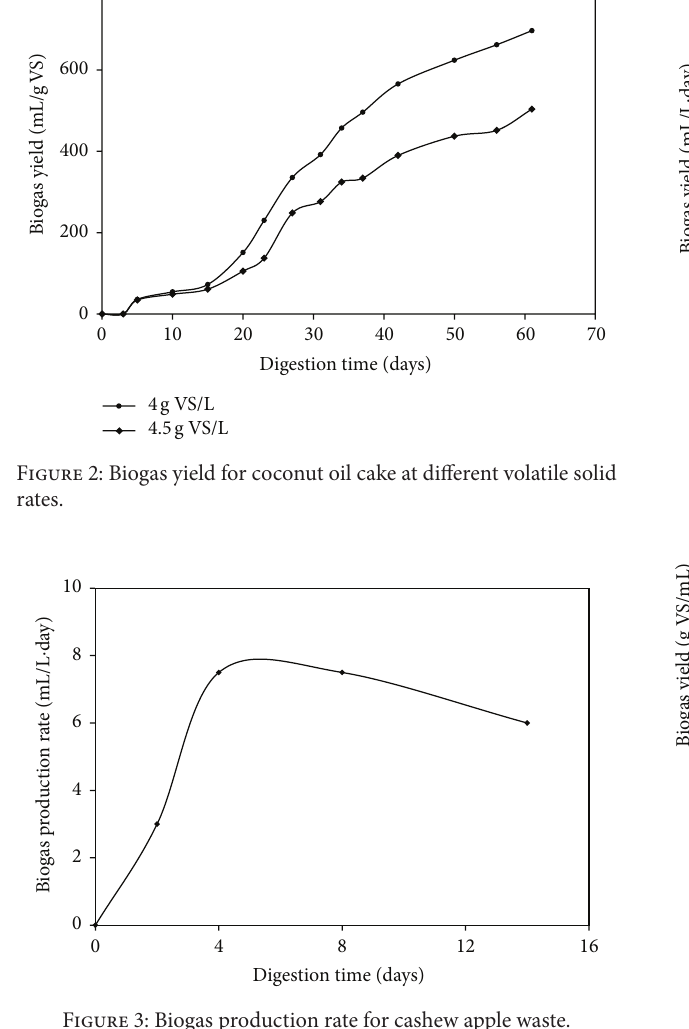
Figure 3: Biogas production rate for cashew apple waste.